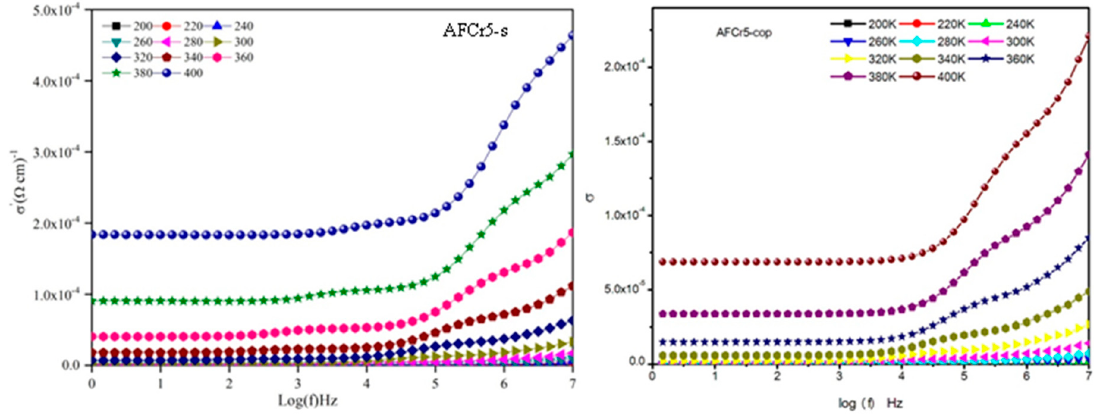
Figure 9. Frequency evolution of the conductivity at di ff erent temperature for AFCr5-s and AFCr5- cop.